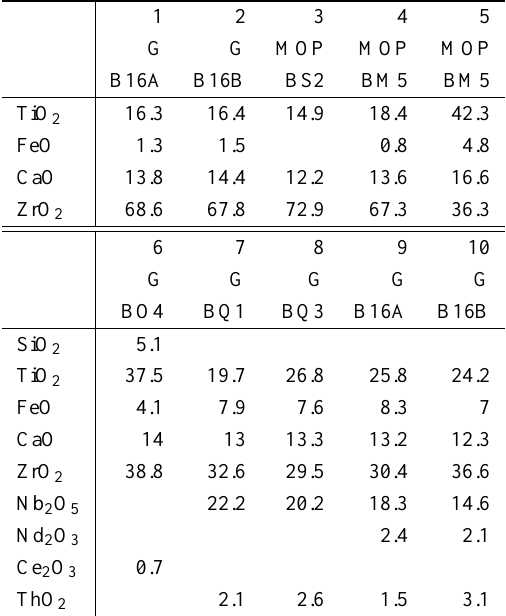
Representative calzirtite (1-4) and zirconolite (5- 10) analyses of Araxá rocks. For rock abbrevia- tions see Table